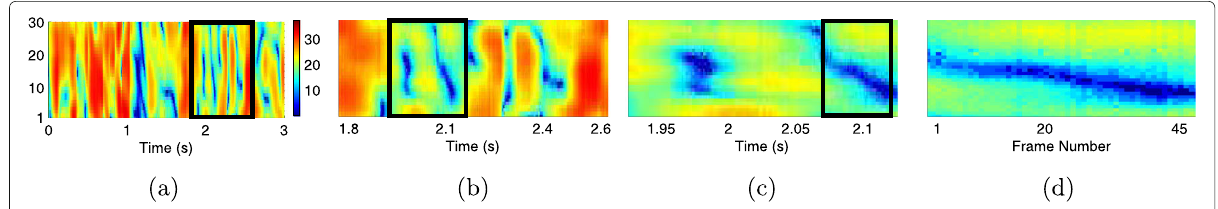
Fig. 3 A highly dynamic LTV channel can become a quasi-LTI channel with a higher sampling rate. a 1x zoomed, b 3.75x zoomed, c 15x zoomed, d 60x